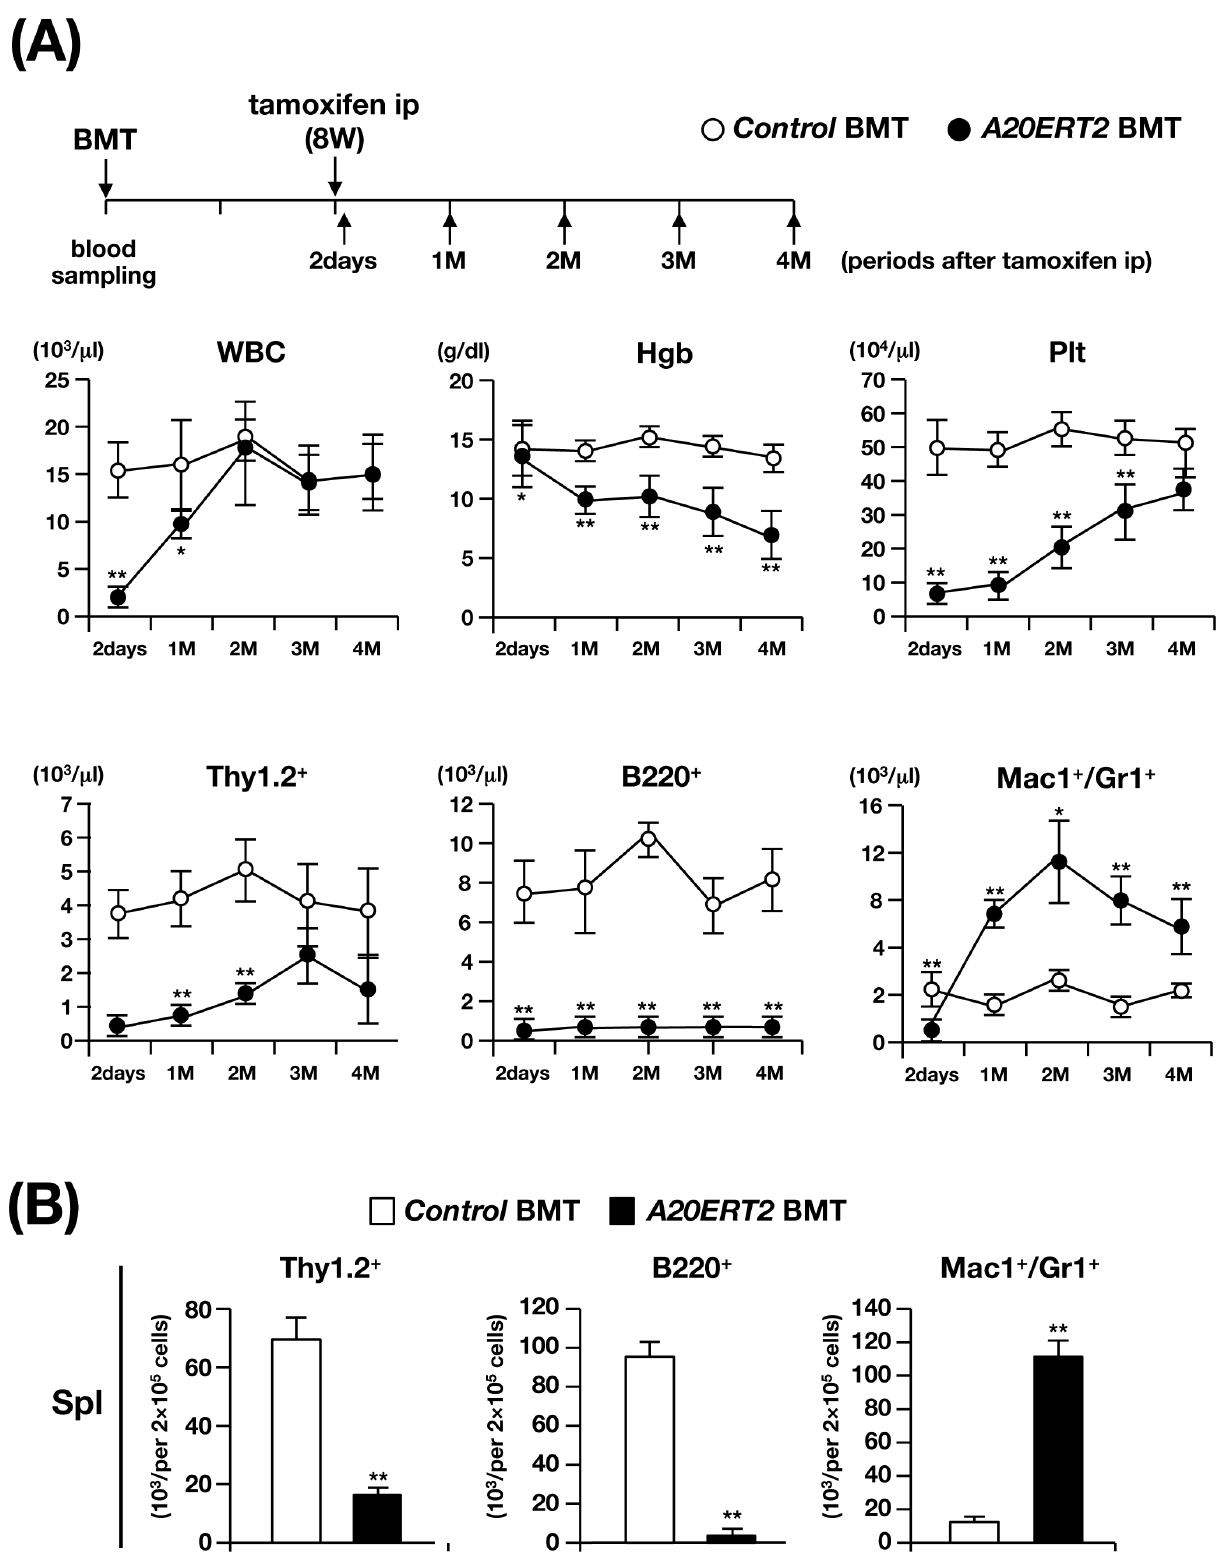
Figure 4. Analysis of control and A20ERT2 BMT mice. (A) Time schedule of BMT, tamoxifen ip, blood sampling, and time-dependent changes in hematopoietic parameters in the PB. **p , 0.01 (Student’s t -test). (B) Percentages of Thy1.2 + , B220 + , and Mac1 + /Gr1 + cells in the spleen 4 M after transplantation. **p , 0.01 (Student’s t -test).